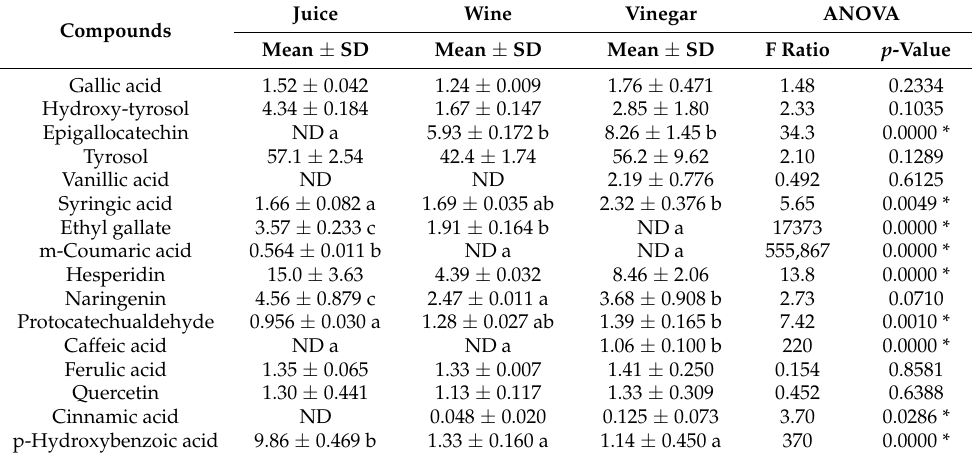
Different letters in the same row indicate significant differences according to Tukey’s test ( p < 0.05). * Values are significant at p < 0.05; ND: Not